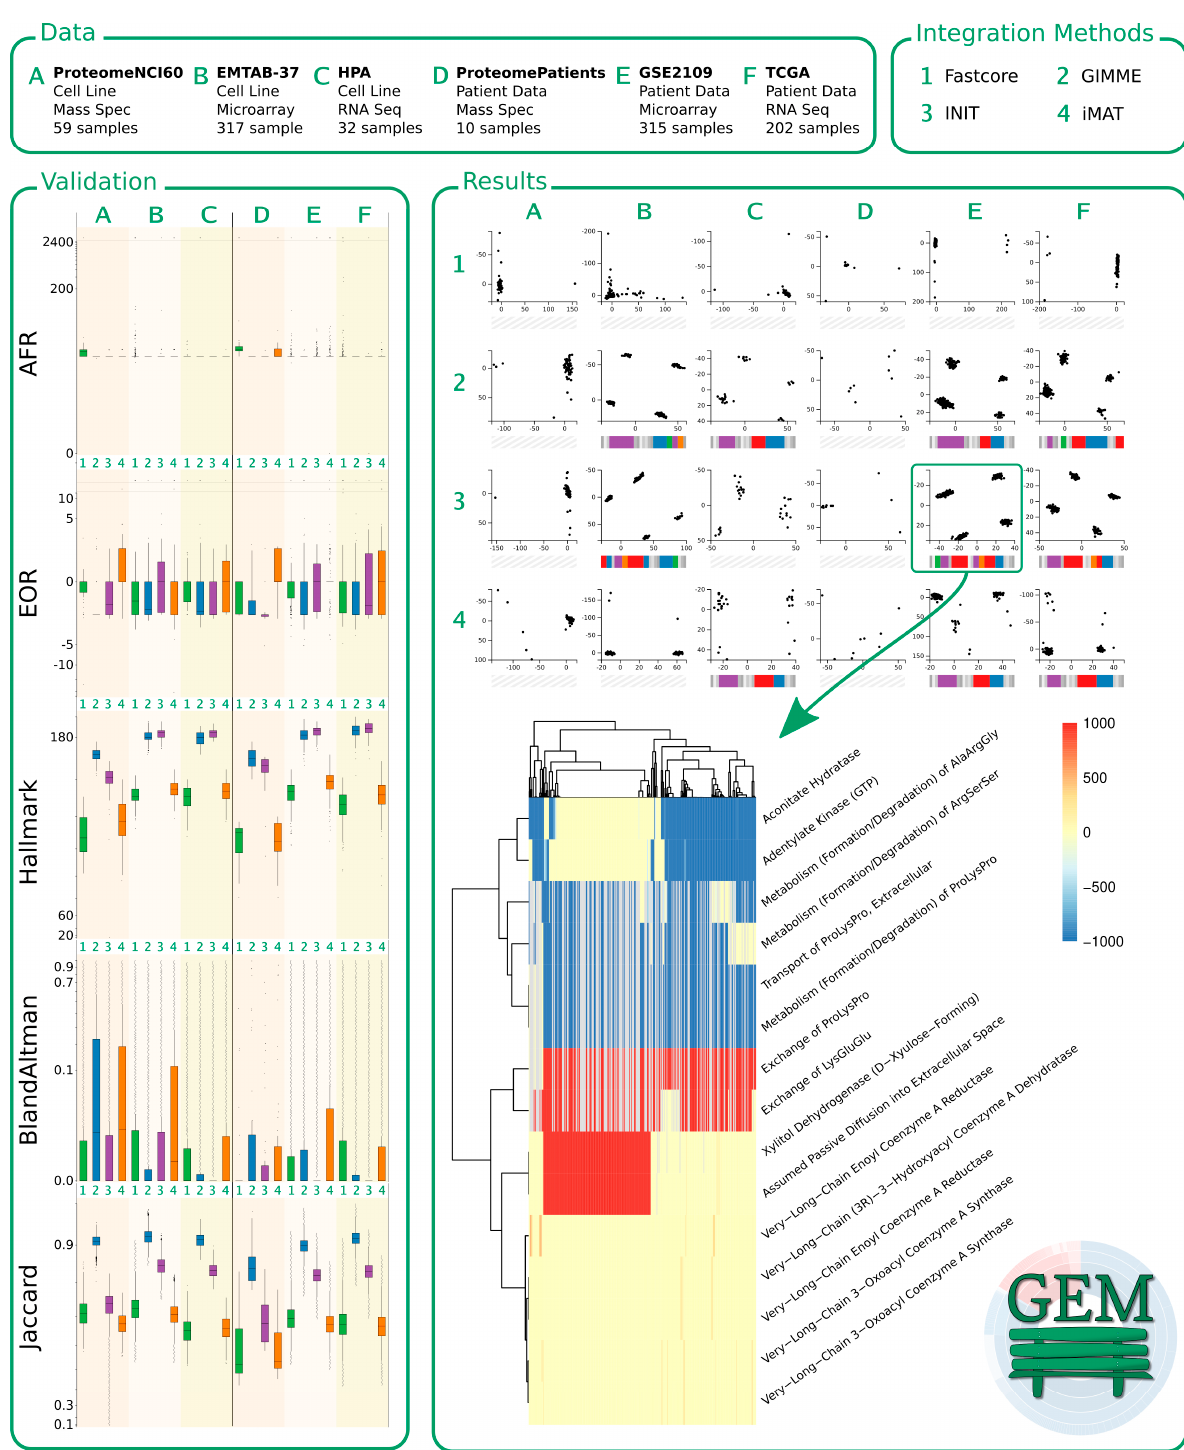
Figure 9. Preview of the GEMbench website. The top of the figure shows some basic information regarding the data (A: NCI-60 Proteome, B: EMTAB-37, C: HPA, D: ProteomePatients, E: GSE2109, and F: TCGA) and integration methods (1: FASTCORE, 2: GIMME, 3: INIT, and 4: iMAT) used in this study. The panel on the left-hand side shows the results of validating our CGEMs. The panel on the right-hand side shows some of the results: at the top can be seen how we distinguished groups of samples using PCA and at the bottom, a corresponding heatmap indicates the results when analyzing the data of 3E (INIT applied to GSE2019) using random